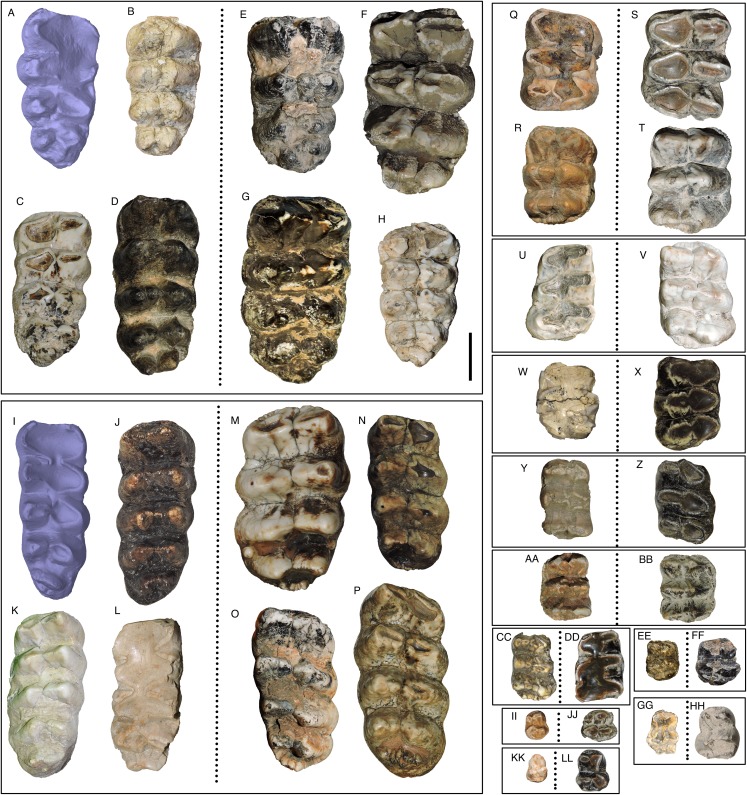
Comparison of sample teeth from Mammut pacificus and Mammut americanum.(A–D) M3 of M. pacificus, (E–H) M3 of M. americanum. Note the presence of a fifth loph in (C and D), and the weak to absent cingulum in all four M. pacificus specimens (contrast with the strong cingulum development in F). (I–L) m3 of M. pacificus, (M–P) m3 of M. americanum. Again, note the absence or weak development of a cingulum in (I–L), and the variable morphology of the posterior to the fourth lophid, particularly in M. americanum. (Q and R) M2 of M. pacificus, (S and T) M2 of M. americanum. Note the weak cingulum development in (Q) and strong development in (R). (U) m2 of M. pacificus, (V) m2 of M. americanum, (W) M1 of M. pacificus, (X) M1 of M. americanum, (Y) m1 of M. pacificus, and (Z) m1 of M. americanum. (AA) dP4 of M. pacificus, (BB) dP4 of M. americanum, (CC) dp4 of M. pacificus, (DD) dp4 of M. americanum, (EE) dP3 of M. pacificus, (FF) dP3 of M. americanum. Note the partial third loph in both taxa, (GG) dp3 of M. pacificus, (HH) dp3 of M. americanum. Note the partial third lophid in both taxa. (II) dP2 of M. pacificus, (JJ) dP2 of M. americanum, (KK) dp2 of M. pacificus, and (LL) dp2 of M. americanum. (A) WSC 18743, M. pacificus holotype right M3, orthographic view of digital model, Riverside County, California, (B) WSC 9964, M. pacificus left M3, Riverside County, California, (C) WSC 10829, M. pacificus left M3, Riverside County, California, (D) UCMP 212936, M. pacificus right M3, Alameda County, California, (E) DMNH 69327, M. americanum left M3, Pitkin County, Colorado, (F) LACM 154685, M. americanum left M3, Allen County, Indiana, (G) LSUMG-V 17071, M. americanum right M3, West Feliciana Parish, Louisiana, (H) CMC VP 145, M. americanum right M3, Clermont County, Ohio, (I) WSC 18743, M. pacificus holotype right m3, orthographic view of digital model, Riverside County, California, (J) LACM HC 87072, M. pacificus left m3, Los Angeles County, California, (K) WSC 19730, M. pacificus left m3, Riverside County, California, (L) LACM 152669, M. pacificus left m3, Ventura County, California, (M) CMC VP 1120, M. americanum left m3, Hamilton County, Ohio, (N) G47, M. americanum right m3, Pinellas County, Florida, (O) JMM VP 20, M. americanum right m3, Wayne County, Indiana, (P) LACM 154598, M. americanum right m3, Cowley County, Kansas, (Q) SBCM 5.3.298, M. pacificus right M2, Riverside County, California, (R) UCMP 1564, M. pacificus right M2, Tuolumne County, California, (S) DMNH 69331, M. americanum left M2, Pitkin County, Colorado, (T) G25650, M. americanum right M2, Darke County, Ohio, (U) LACM 130515, M. pacificus left m2, San Luis Obispo County, California, (V) G25650, M. americanum right m2, Darke County, Ohio, (W) WSC 9964, M. pacificus left M1, Riverside County, California, (X) DMNH 70776, M. americanum right M1, Pitkin County, Colorado, (Y) LACM 128927, M. pacificus right m1, San Luis Obispo County, California, and (Z) DMNH 70775, M. americanum right m1, Pitkin County, Colorado. (AA) WSC 180, M. pacificus left dP4, Riverside County, California, (BB) G25693, M. americanum right dP4, Darke County, Ohio, (CC) LACM HC 475, M. pacificus right dp4, Los Angeles County, California, (DD) DMNH 70785, M. americanum left dp4, Pitkin County, Colorado, (EE) LACM P23 4766, M. pacificus right dP3, Los Angeles County, California, (FF) VMNH 51132, M. americanum left dP3, Smyth County, Virginia, (GG) LACM HC 1631, M. pacificus left dp3, Los Angeles County, California, (HH) DMNH 70794, M. americanum left dp3, Pitkin County California, (II) WSC 180, M. pacificus left dP2, Riverside County, California, (JJ) G25693, M. americanum left dP2, Darke County, Ohio, (KK) UCMP 8204, M. pacificus left dp2, Shasta County, California, and (LL) DMNH 70795, M. americanum right dp2, Pitkin County, Colorado. Scale = 10 cm.